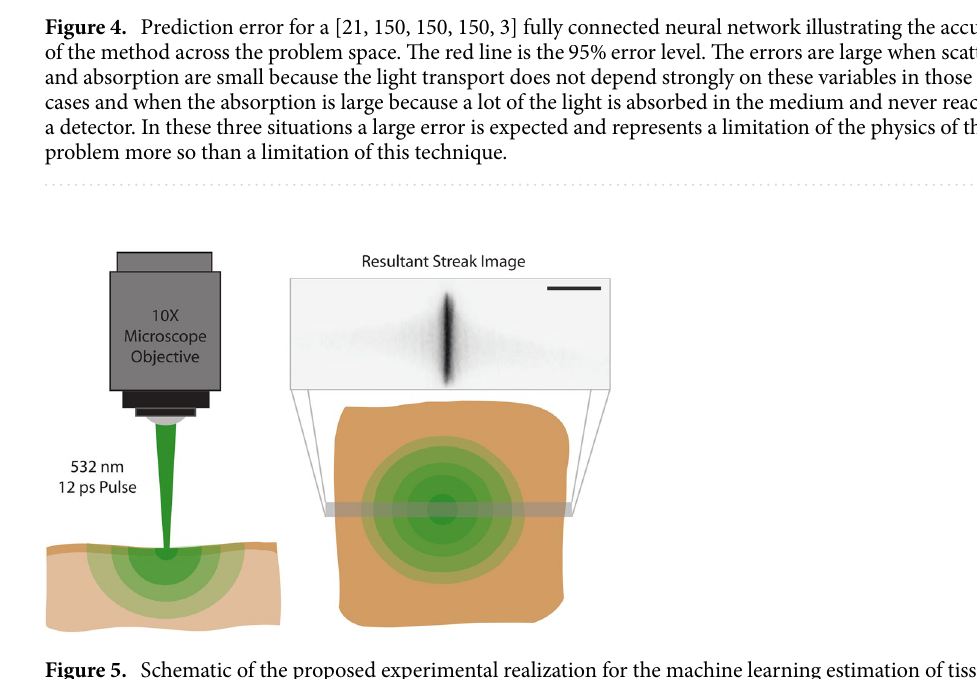
Figure 5. Schematic of the proposed experimental realization for the machine learning estimation of tissue optical properties. The gray line on the right corresponds to the section of tissue that would be imaged to the entrance slit of the streak camera. Scale bar is 150 µ